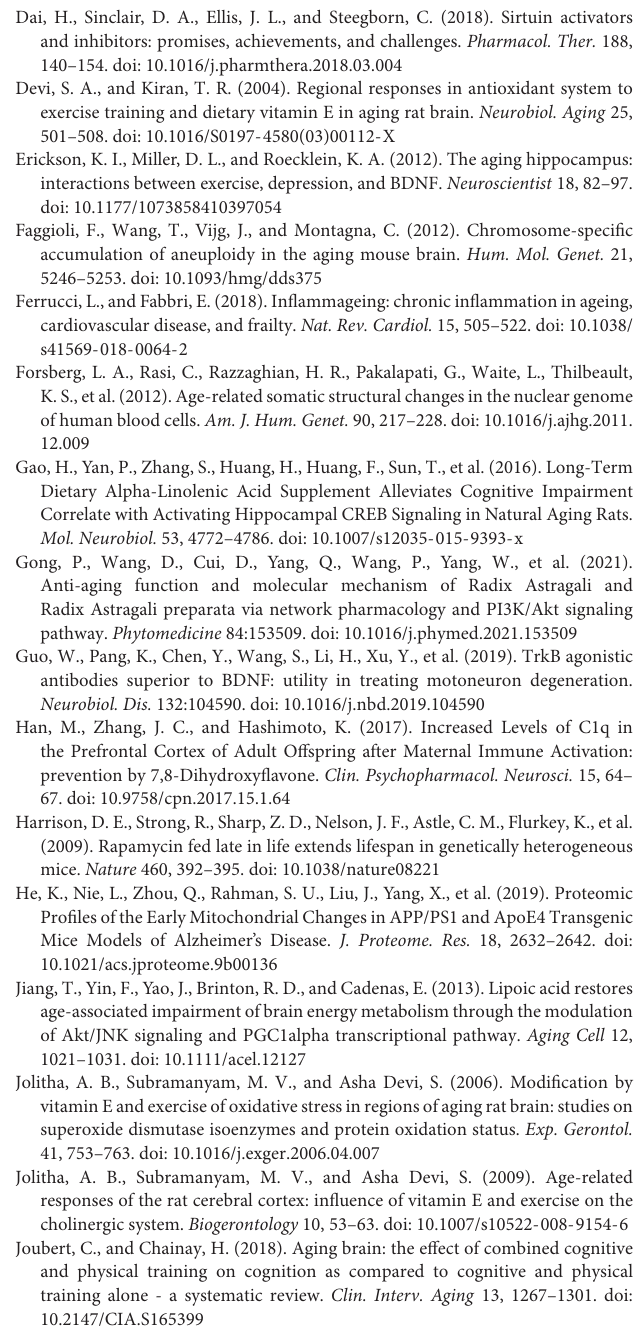
Supplementary Figure 4 | The seed oil demonstrated no toxic effects on tissues. HE staining of the slice from heart, liver, spleen, kidney, and lung of aging mice with oil treatment or not. Supplementary Table 1 | Differentially expressed proteins between the aging control mice and young control mice. Supplementary Table 2 | Differentially expressed proteins between the aging mice treated with acer truncatum seed oil and aging control